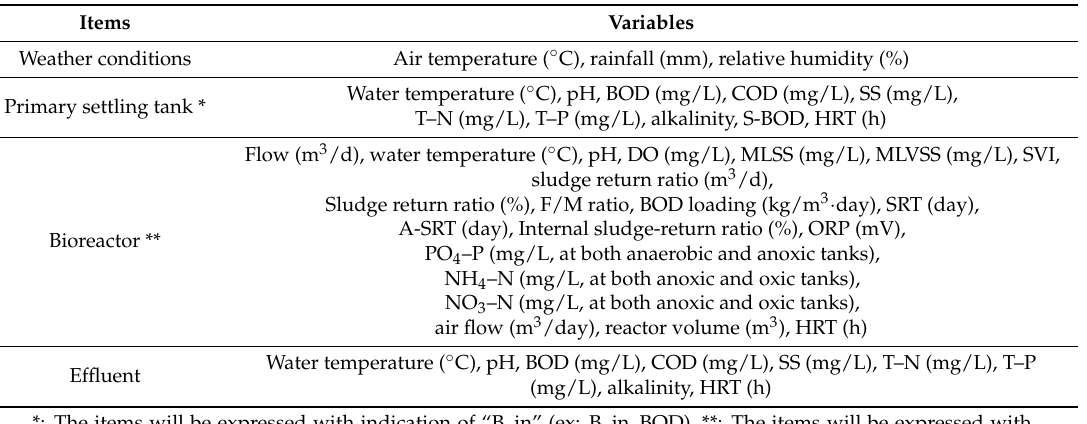
Table 1. Collected data